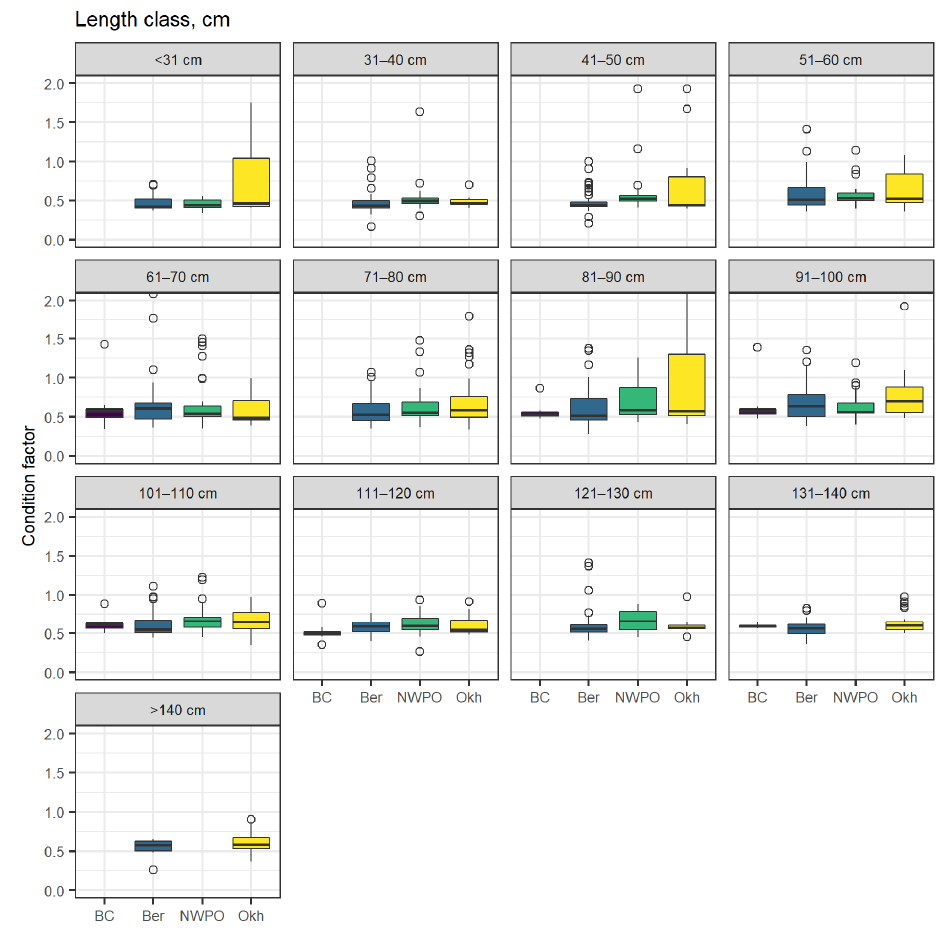
Figure 14. Boxplots of condition factor of the Aleutian skate Bathyraja aleutica of different size classes from different locations; BC—the waters off British Columbia, Ber—the Bering Sea, NWPO—the northwestern Pacific Ocean, Okh—the Sea of Okhotsk. Circles denote outliers. Brackets with asterisks show p -values of the pairwise two-sided Wilcoxon tests with Holm p -value adjustment (* means p < 0.05, ** p < 0.005, **** p < 0.0005).